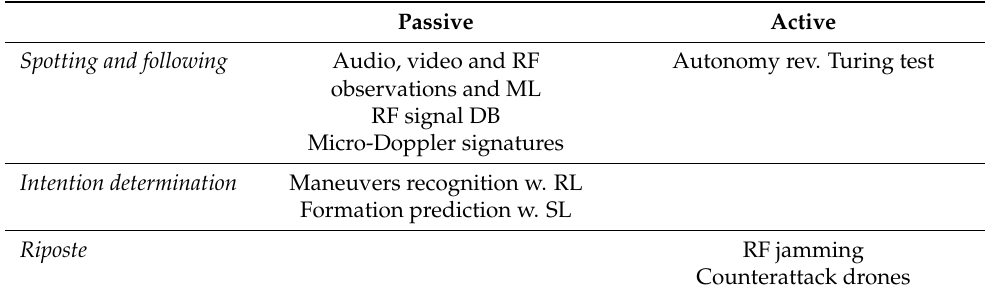
Table 1. Tackling the countering drone threats. The first column lists the tasks. The second column provides passive solutions based solely on observations. The third column indicates active solutions, acting on threatening drone behavior.